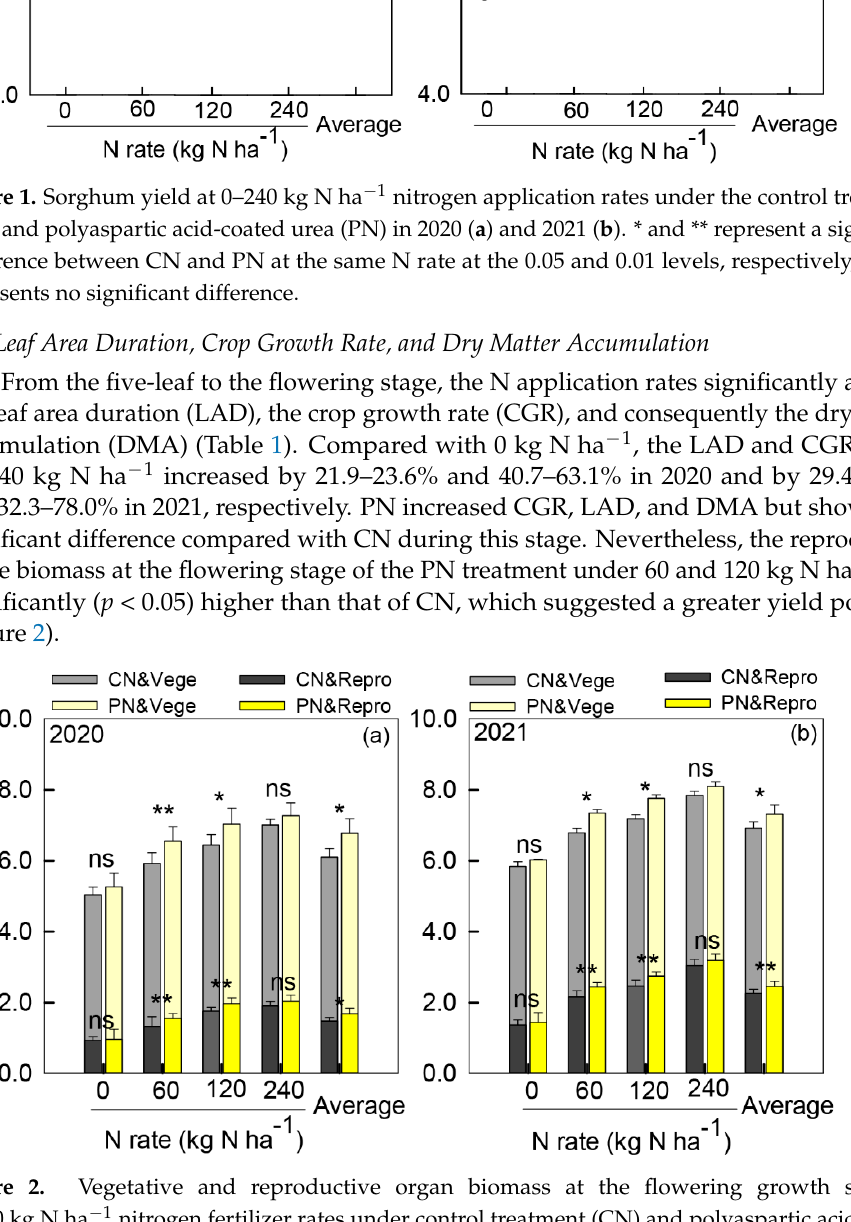
Figure 2. Vegetative and reproductive organ biomass at the flowering growth stage at 0 − 240 kg N ha − 1 nitrogen fertilizer rates under control treatment (CN) and polyaspartic acid-coated urea (PN) in 2020 ( a ) and 2021 ( b ). * and ** represent a significant difference between CN and PN at the same N rate at the 0.05 and 0.01 levels, respectively, and ns represents no significant difference.